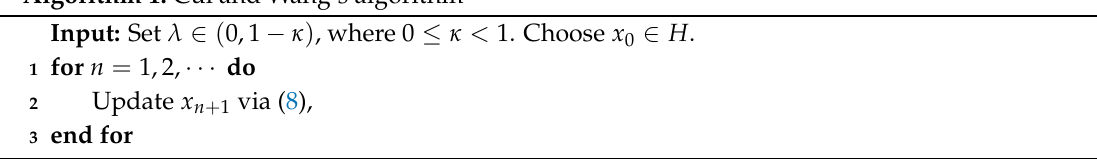
Algorithm 1: Cui and Wang’s algorithm